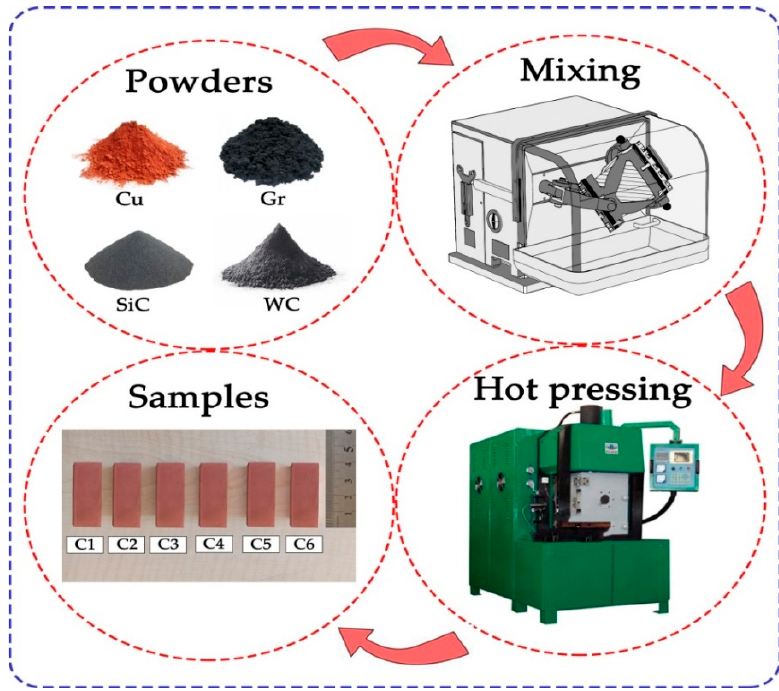
Figure 3. Fabrication scheme of composites.